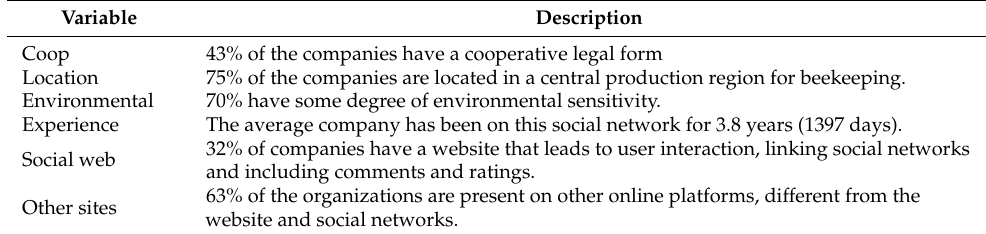
Table 2. Descriptive values of the variables